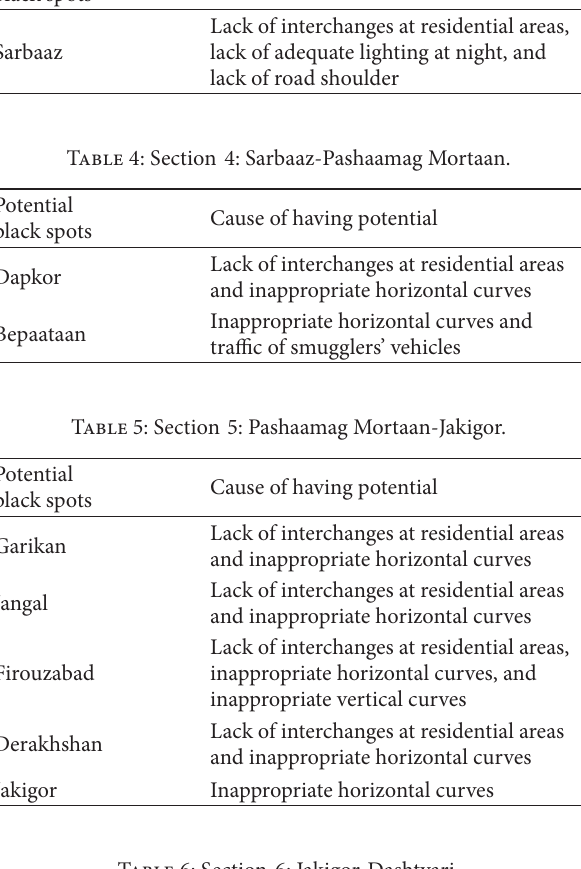
Table 6: Section 6: Jakigor-Dashtyari.